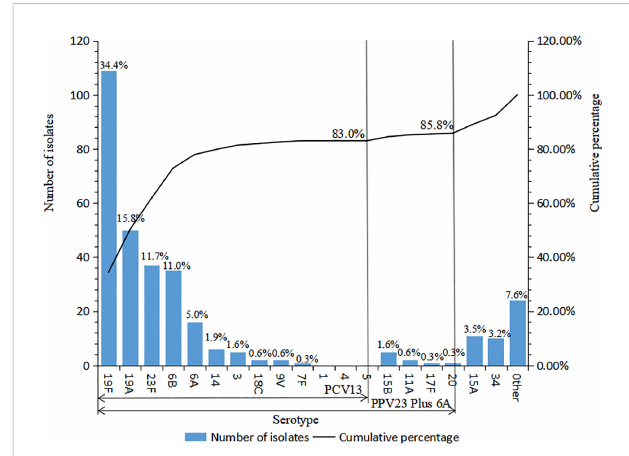
FIGURE 1 Serotype distribution of 317 S. pneumoniae strains isolated in Urumqi Children ’ s Hospital during 2014-2021" .The note of Figure 1 is "Other serotypes included 4 strains of type 6C, 3 strains of each type 23A, 7C, 16F, 2 strains of type 42, and 1 strain of each type 29, 13, 37, 23B, 21, 15C, 10C, 28A, and